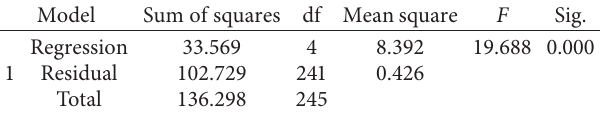
Table 5: ANOVA results of the regression analysis.